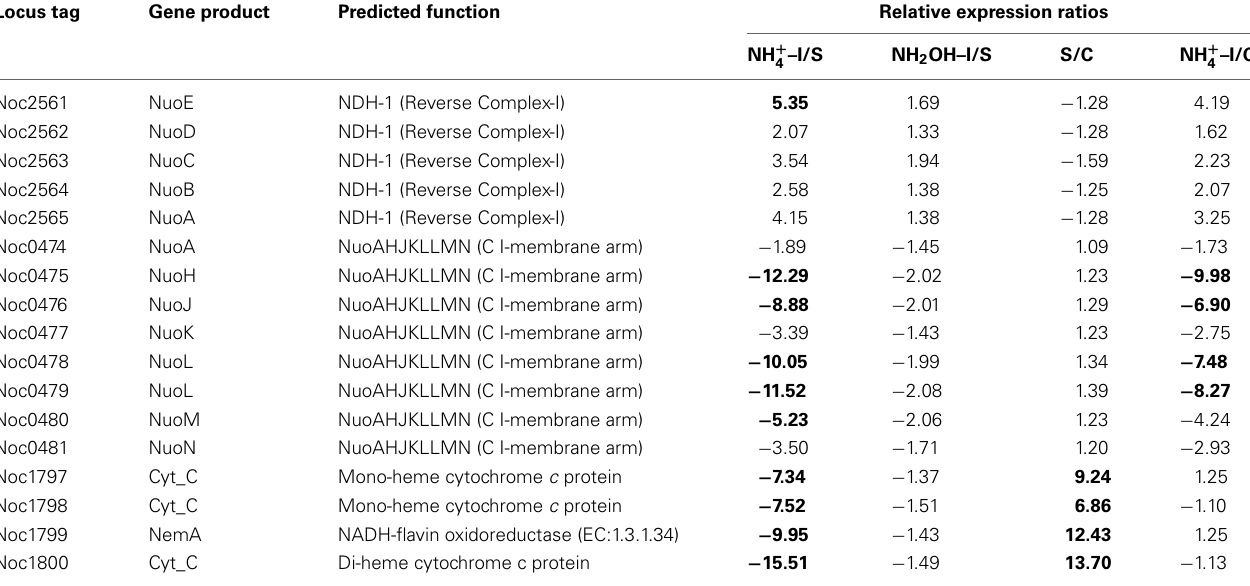
Values represent average ratios from four hybridization experiments per gene, per treatment. Bolded ratios indicate those that are considered to have significant differences (changes greater than 5-fold) in gene expression between compared treatments. Values in parentheses represent ratios from qPCR experiments reported previously (Graham et al., 2011) employing the same RNA preparations as used for the microarray hybridizations. Values in bold indicate that both methods yielded consistent results.